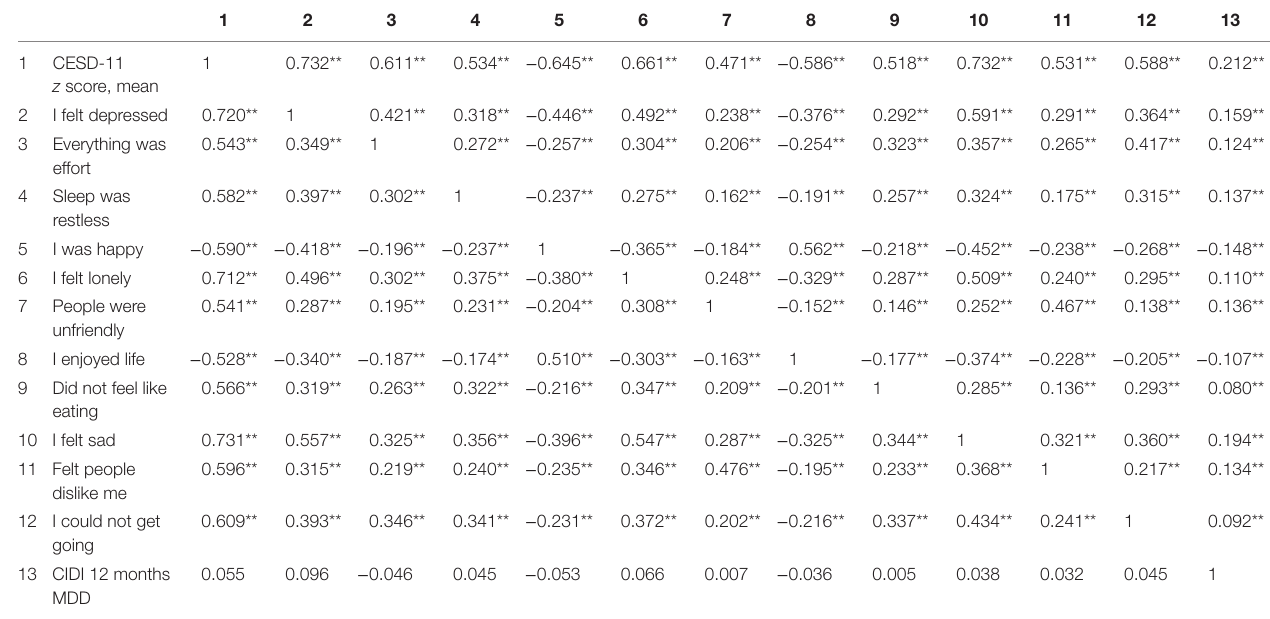
TaBle 4 | Unadjusted correlations between baseline ces-D total score, ces-D items, and ciDi-based MDD after 15 years based on ethnicity.